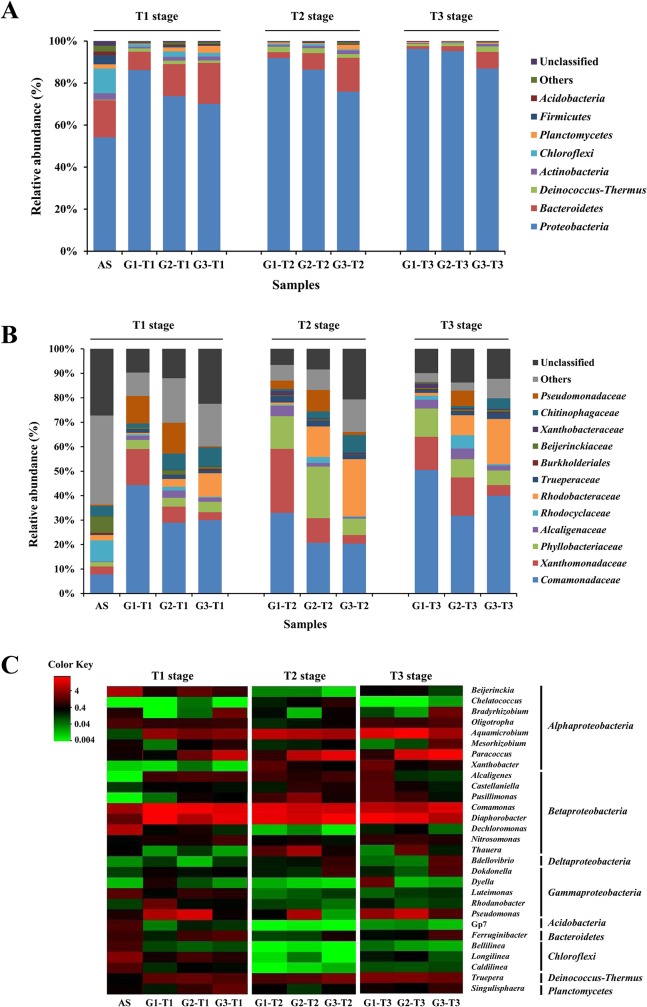
Taxonomic classification of sequences from bacterial communities of the three groups.
A. Relative abundance of the dominant phyla in each group at different stages. B. Relative abundance of the dominant families in each group at different stages. C. Heat map of the 10 most abundant genera in each group at different stages. The color intensity in each cell showed the abundance of a genus in a group. RDP classifier was used to assign the sequences to different taxonomic levels at 50% threshold, and the abundances were displayed as percentage of the total sequences in each group.